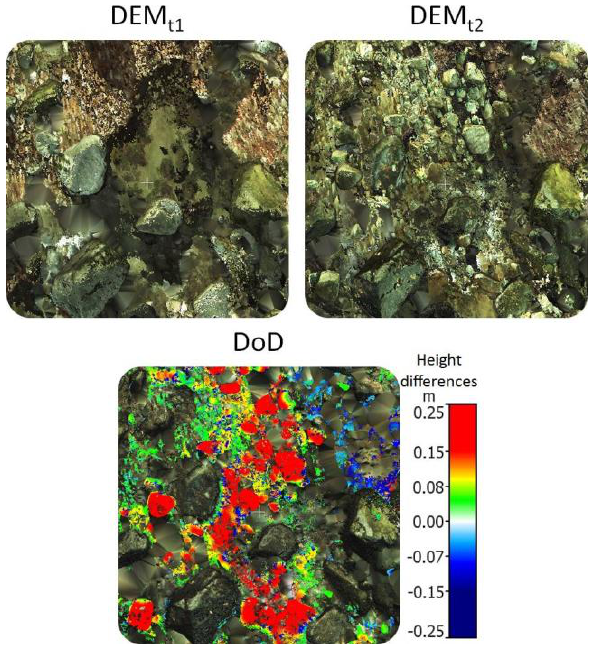
Figure 1. Example of created DoD